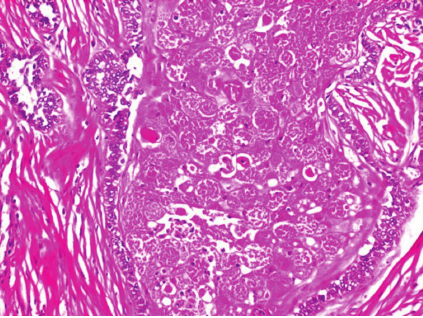
Figure 7: Moderate staining of Bcl-2 was expressed by the periph- eral columnar cells of tumor islands and negative in the granular cells (40x).